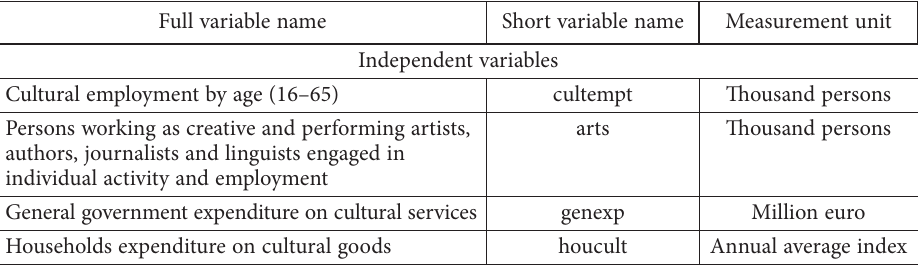
Table 2. Variables of the research (source: compiled by the author)